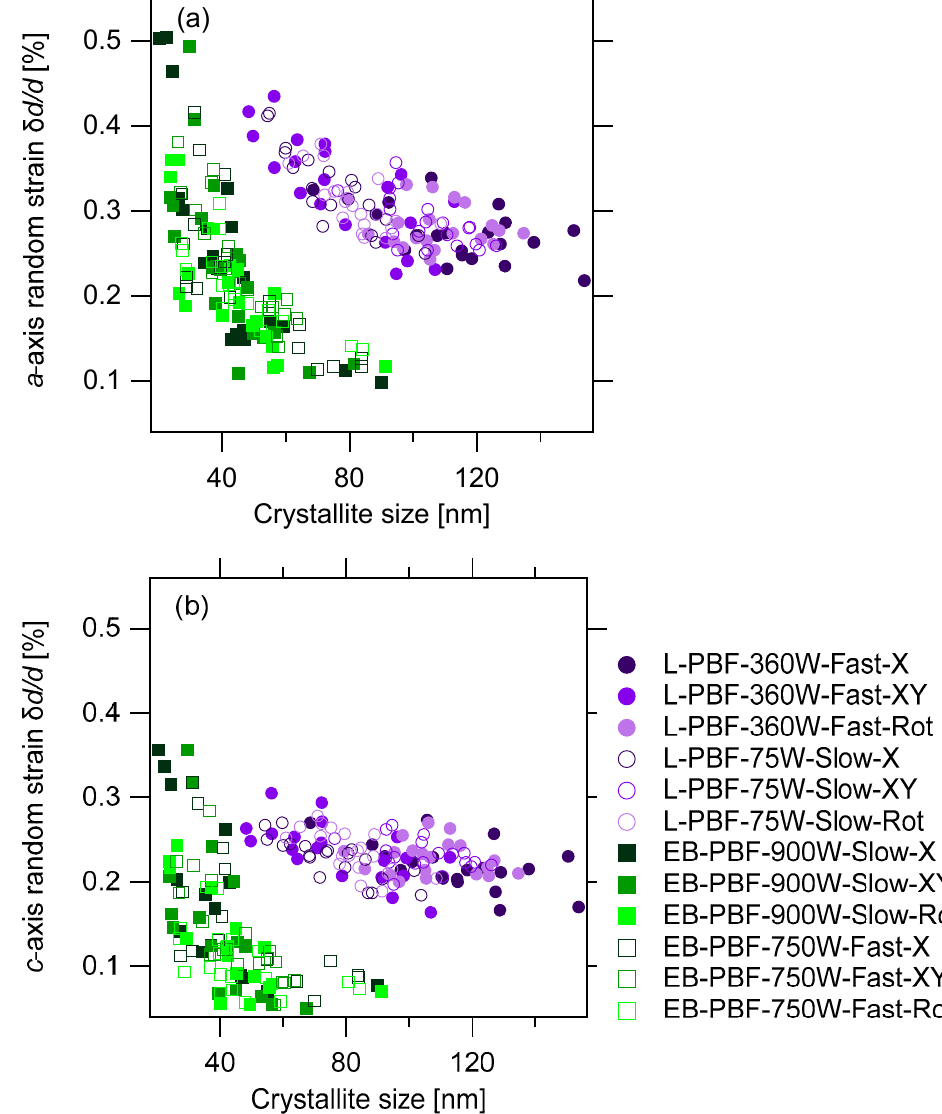
Figure 5. Crystallite size of the α or α ’ phase versus random lattice strain of the α or α ’ phase scatter plots for all L-PBF and EB-PBF parts. Random lattice strain in ( a ) the a -axis and ( b ) the c -axis directions. A correlation between the crystallite size and the random lattice strain, and the separation of the L-PBF and EB-PBF data points are seen.